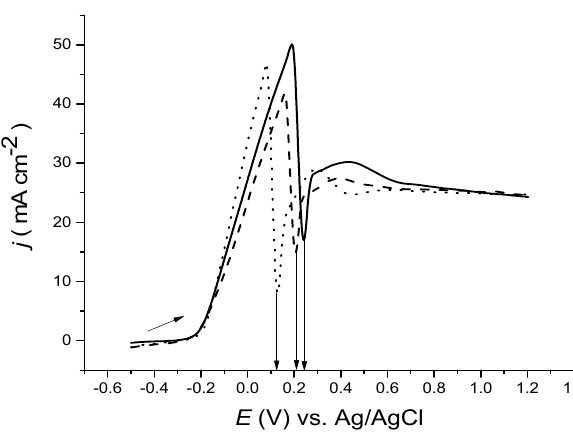
Figure 3. The influence of electrolyte composition on the equilibrium passivation potential of copper disc electrodes in ethaline ChCl:EG, 1:2 (solid line); ChCl:EG, 1:3 (dashed line); and ChCl:EG, 1:4 (dotted line).